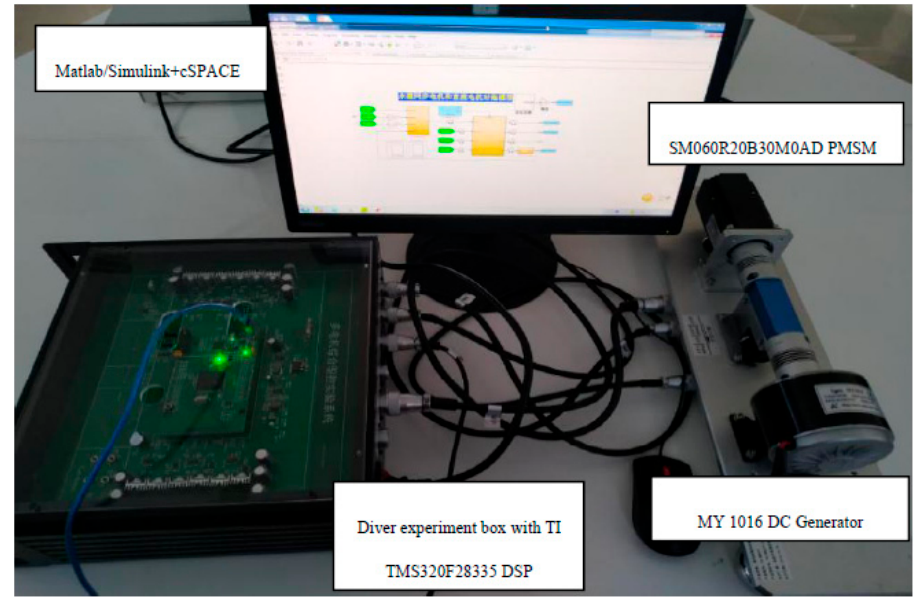
Figure 7. The PMSM experimental platform.